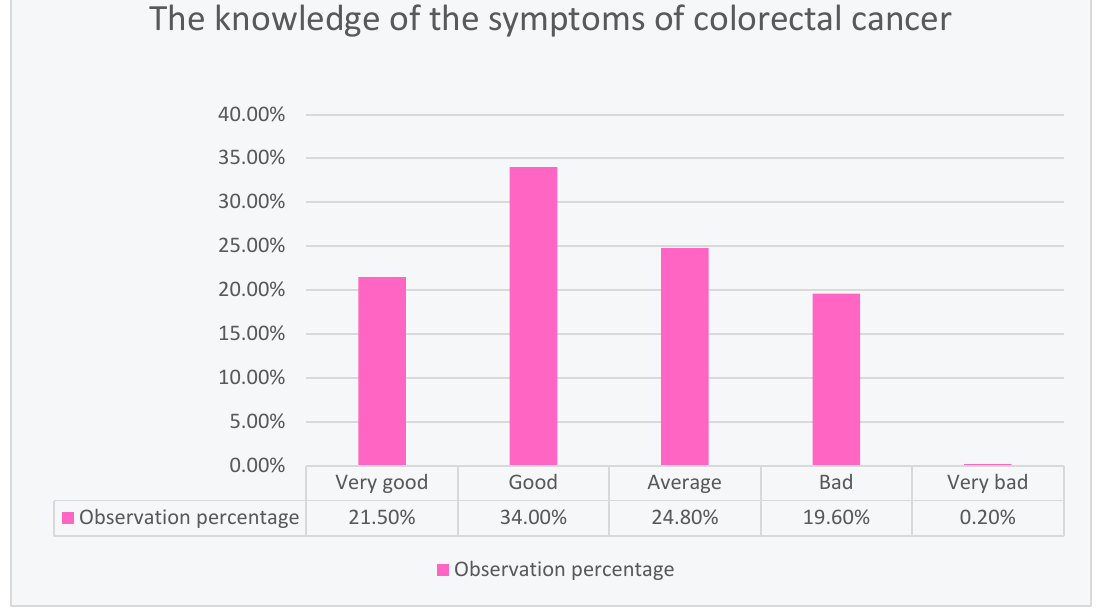
Figure 5. Descriptive scale of respondents’ knowledge about colorectal cancer symptoms.